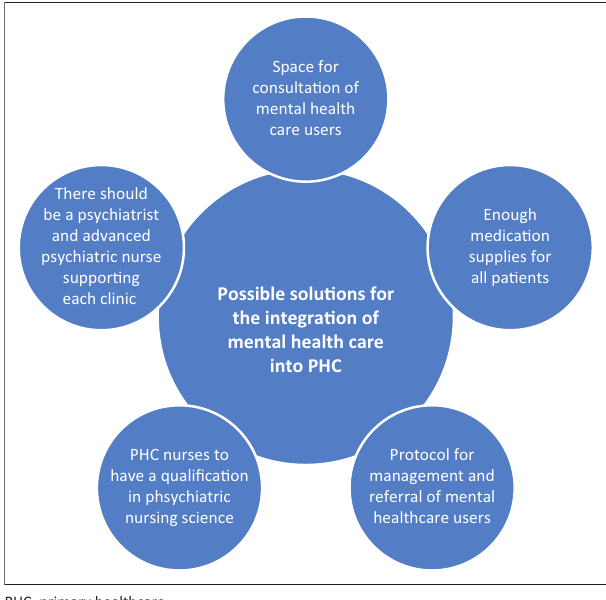
FIGURE 1: Possible solutions for the integration of mental healthcare into primary